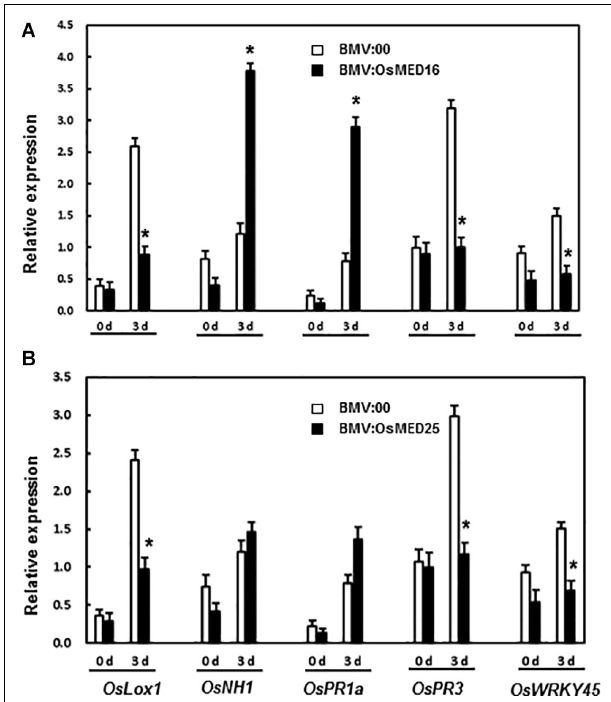
FIGURE 8 | The expression pattern of defense-related genes in BMV:OsMED16- (A) and BMV:OsMED25-infiltrated plants (B) before and after Magnaporthe grisea inoculation. The expression of defense related genes was analyzed by qRT-PCR. Expression data were normalized against OsActin gene, and relative expression is shown as fold expression of OsActin . Data are presented as means ± SD from three independent experiments and * above the columns indicate significant differences at p < 0.05 between the silenced plants and the